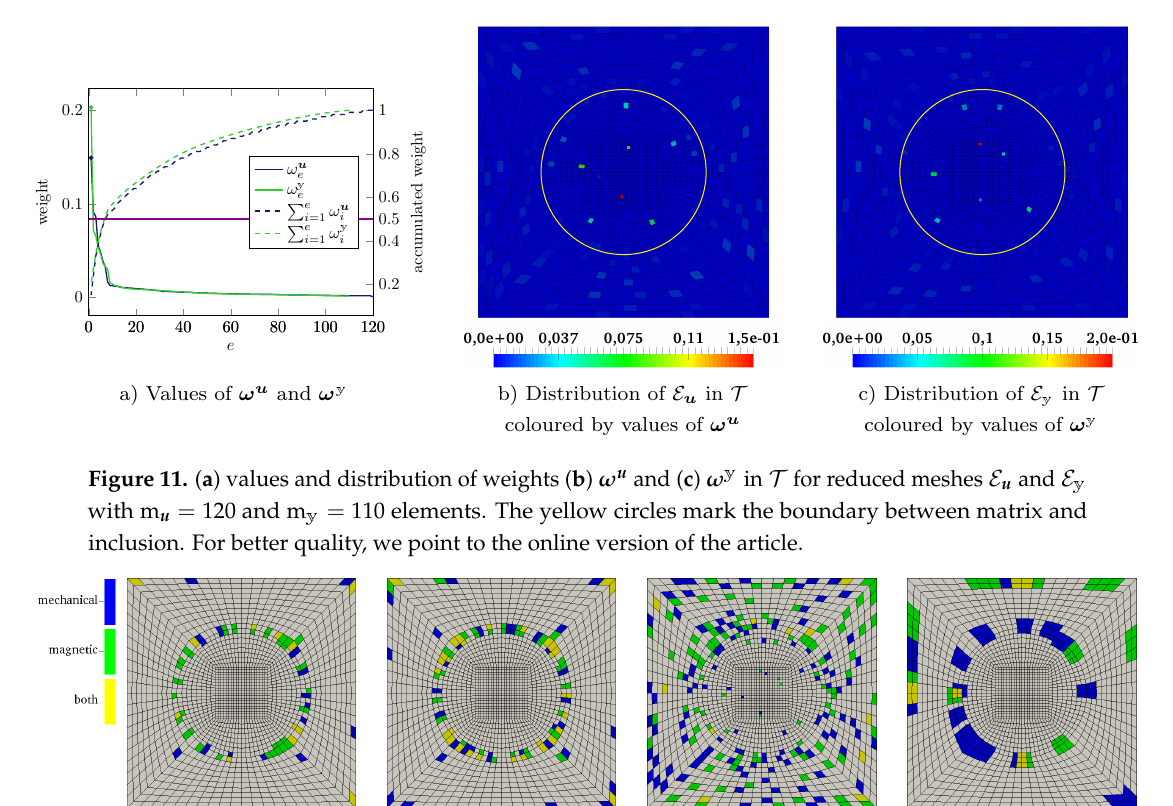
Figure 12. Elements in relevant for the hyper-reduced models in Table 4. T